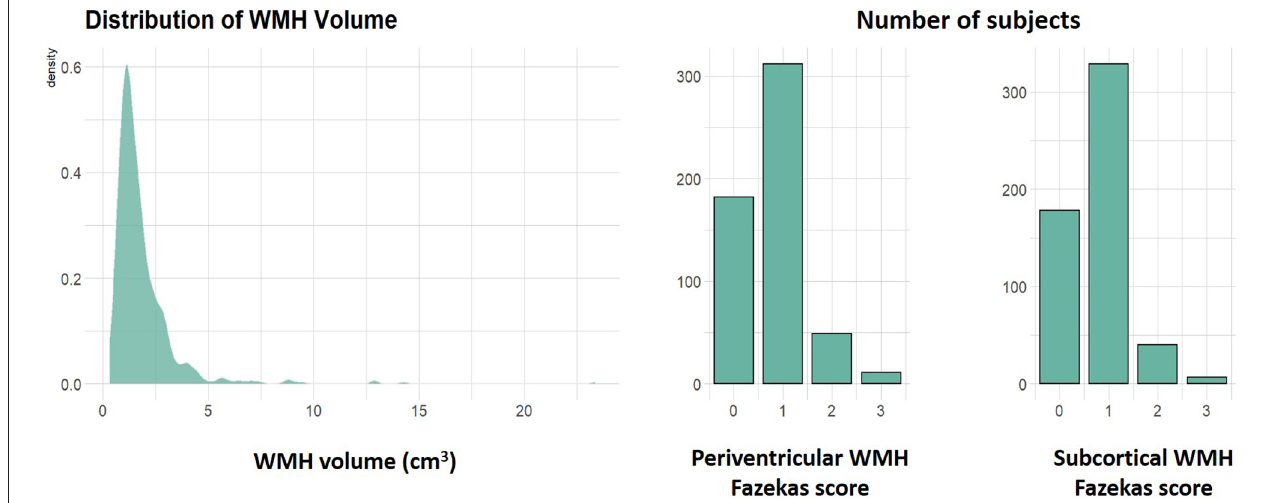
FIGURE 3 | Distribution of white matter hyperintensities (WMH) volumes among participants as well as histograms showing numbers of subjects with normal (scores 0–1) and pathological (scores 2–3) amount of periventricular and subcortical WMH according to the Fazekas scale.